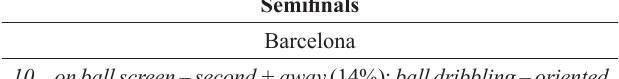
Table 4. SCDs-SPDs for the two most recurrent interaction patterns (i.e., ‘10’ and ‘11’) for all teams in both semi- and final phases. Values expressed in percentage (%) relative to the interaction sequence